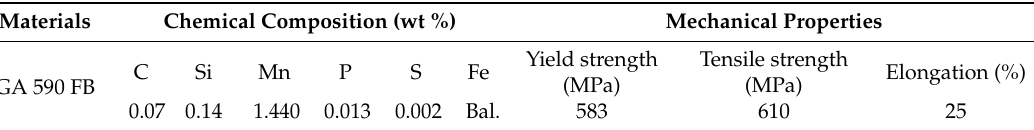
Table 1. Chemical composition and mechanical properties of the base material (FB: Ferrite-bainite).